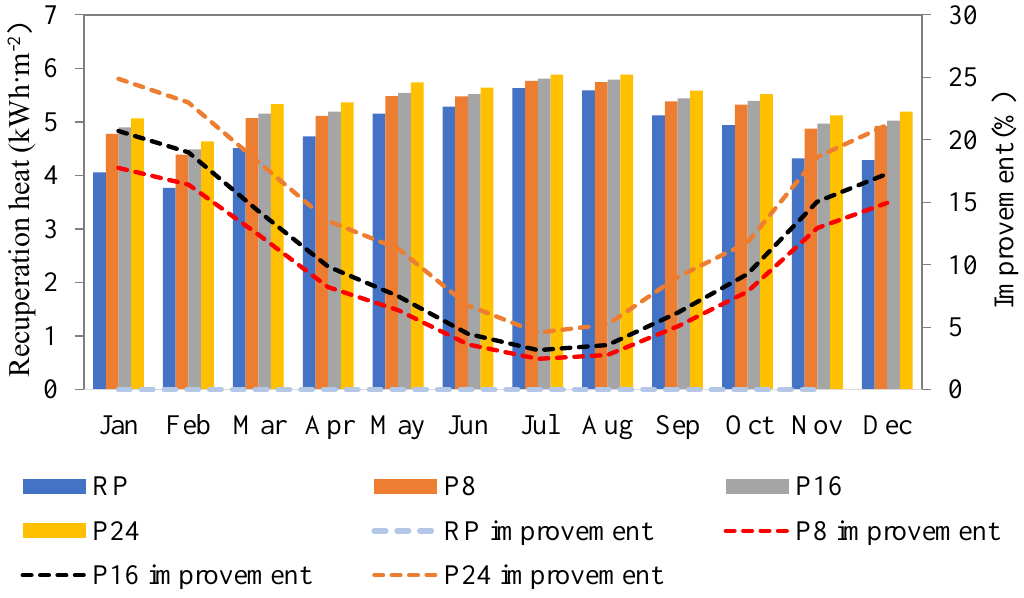
Figure 7. Monthly benefits associated with the utilization of recuperation heat in Prague.